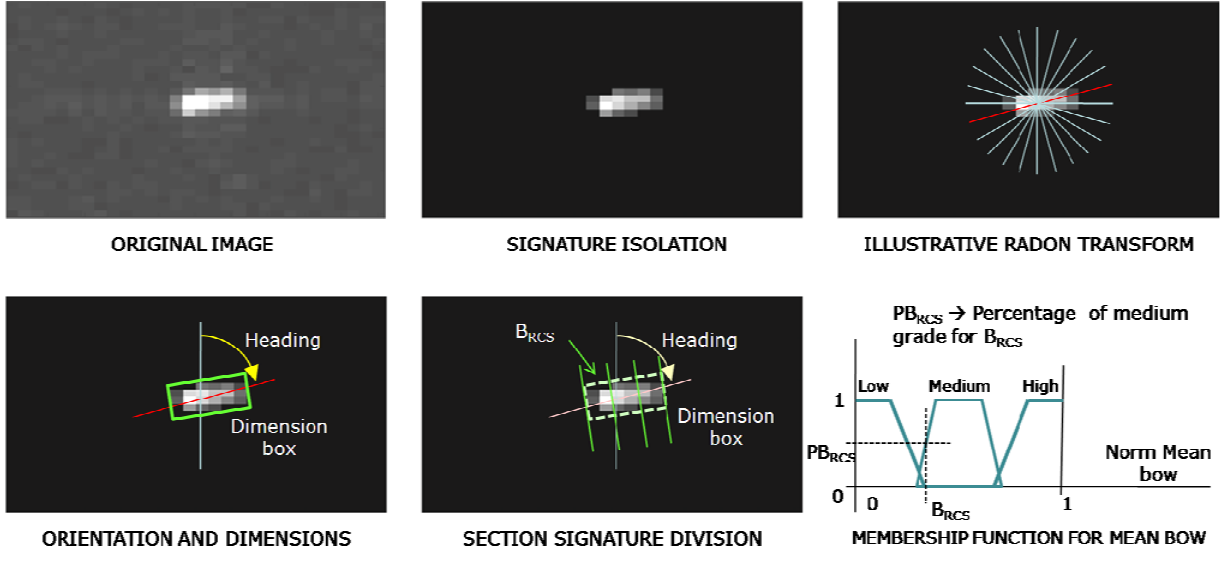
Figure 5. Illustrative description of ship classification without taking fuzzy logic processing into account.